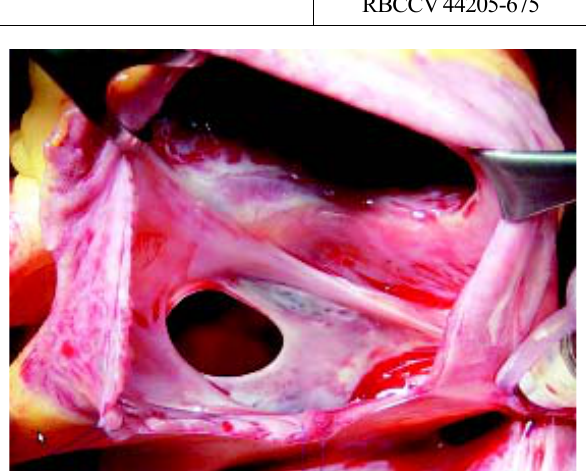
Fig. 1 – Comunicação interatrial tipo ostium secundum, com bordas delgadas e pequenas fenestrações